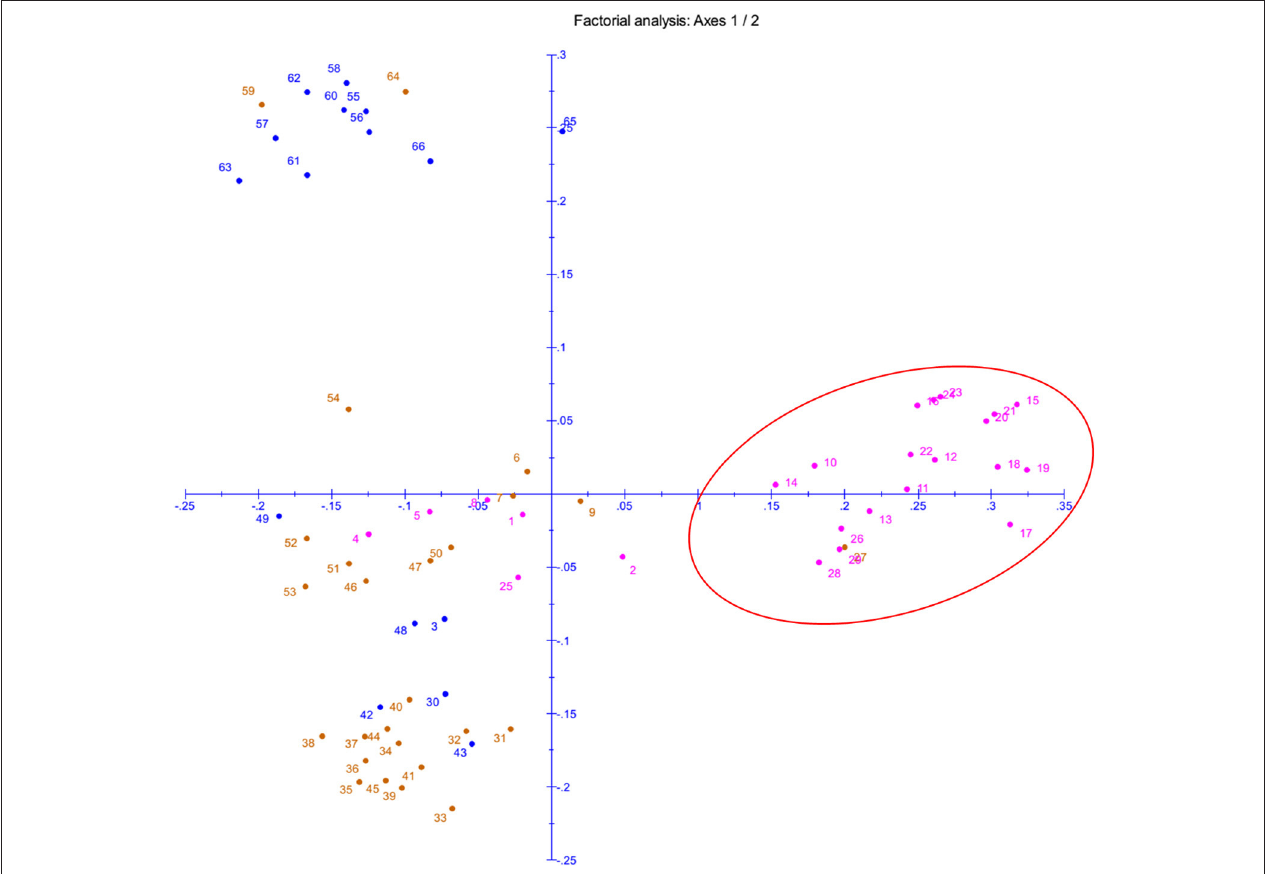
FIGURE 3 | Principal Coordinate Analysis (PCoA) of panel population based on seedling stage cold tolerance linked 58 SSRs and 2 gene specific markers. The numbers in the figure represent the serial number of the genotypes enlisted in Table 1